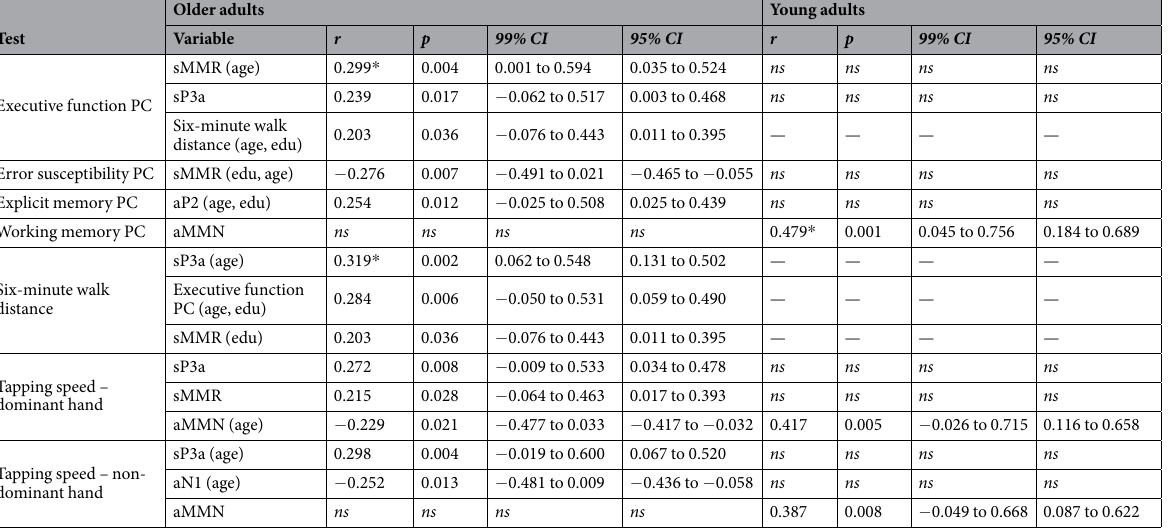
Table 4. Correlations between cognitive and physical measures and ERPs. Variables that show correlation at least in one of the groups within 95% CI are listed; those showing significant correlation within 99% CI are marked with * . Age and/or education (edu) in parentheses refers to significant partial correlations after controlling for the mentioned variable. r , Pearson’s correlation coefficient (bootstrap statistics with 1000 iterations); p , significance (one-tailed); CI , confidence interval; ns , non–significant; − , not measured within the young adult